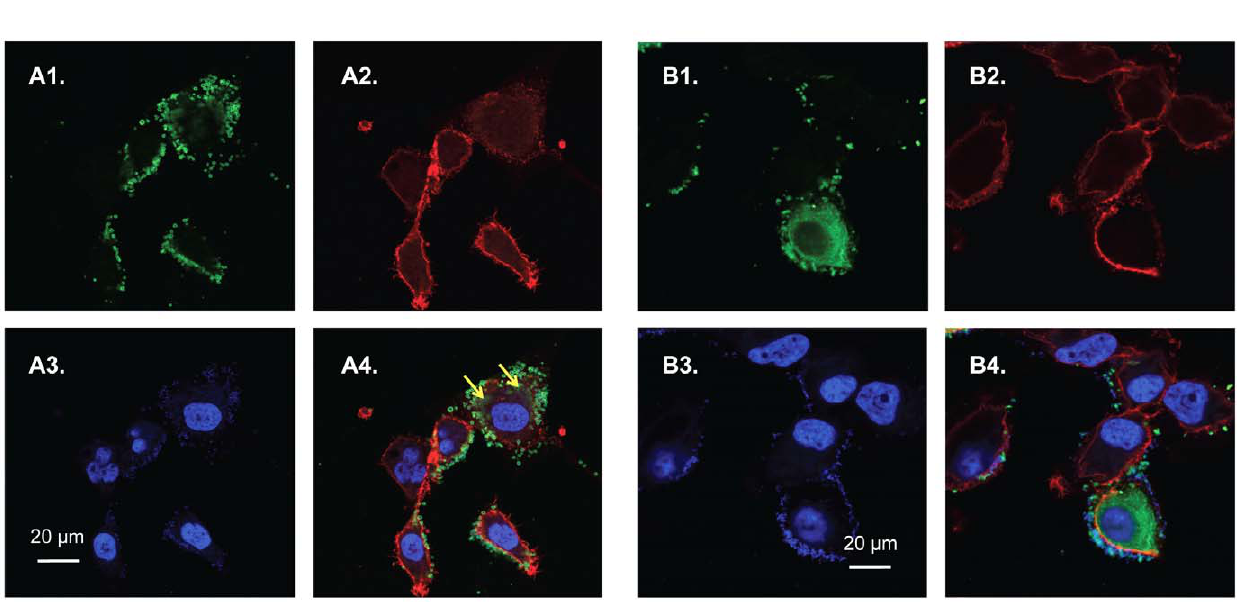
Figure 3. Interaction between CnMVs and HBMECs. ( A ) HBMECs were incubated with purified CnMVs and then examined by confocal microscopy. The HBMECs were stained with FITC-conjugated anti-GFP (A1), rhodamine-conjugated anti-CD44 (A2), and DAPI (A3). An overlaid image of A1, A2 and A3 is shown in A4. The yellow arrows indicate faint, diffuse staining in the cytoplasm of HBMECs. Bar: 20 m m. ( B ) HBMECs were incubated with JB02 C. neoformans cells and then examined by confocal microscopy. The HBMECs were stained with FITC-conjugated anti-GFP (B1), rhodamine-conjugated anti-CD44 (B2), and DAPI (B3). An overlaid image of B1, B2 and B3 is shown in B4. Bar: 20 m m.